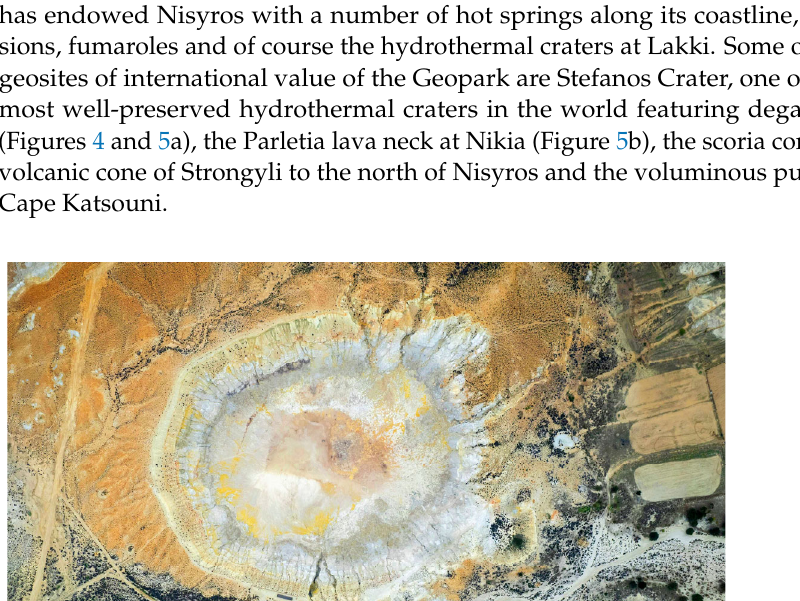
Figure 5. Nisyros is a prime example of an open volcanological laboratory, featuring a number of geological features of great educational and scientific interest: ( a ) Active fumarole within the bottom